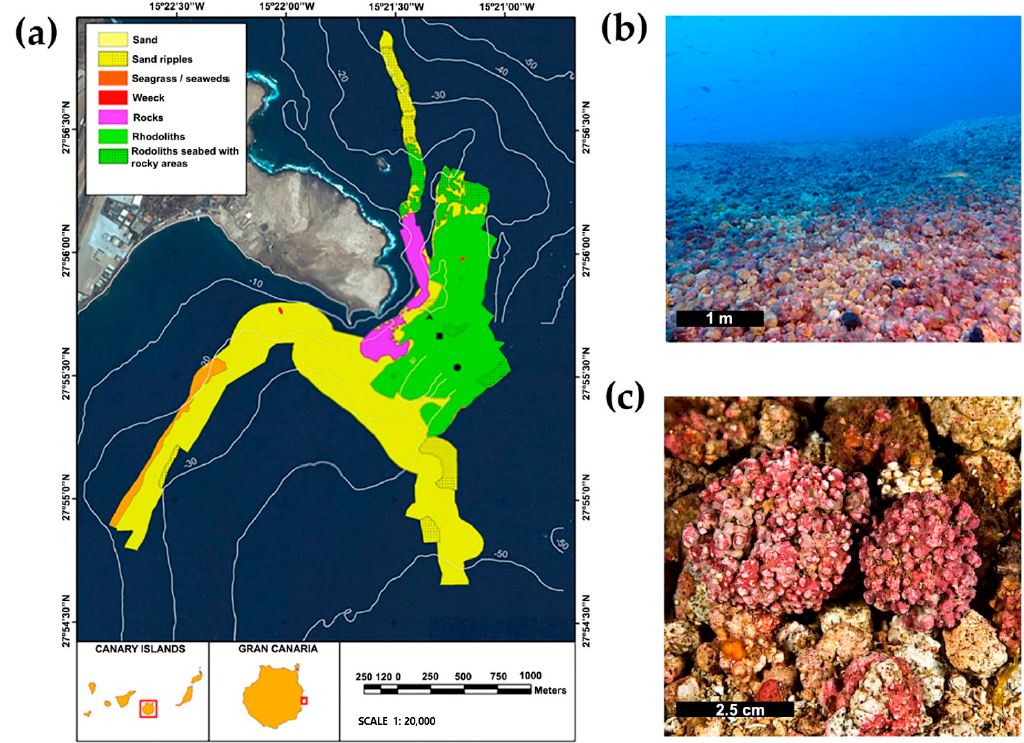
Figure 1. ( a ) Location of the study area at Gran Canaria Island, showing the three sampling sites at 18 m (triangle), 25 m (square), and 40 m (circle); figure adapted from [26]. ( b ) Rhodolith beds. ( c ) Nodules of rhodoliths.